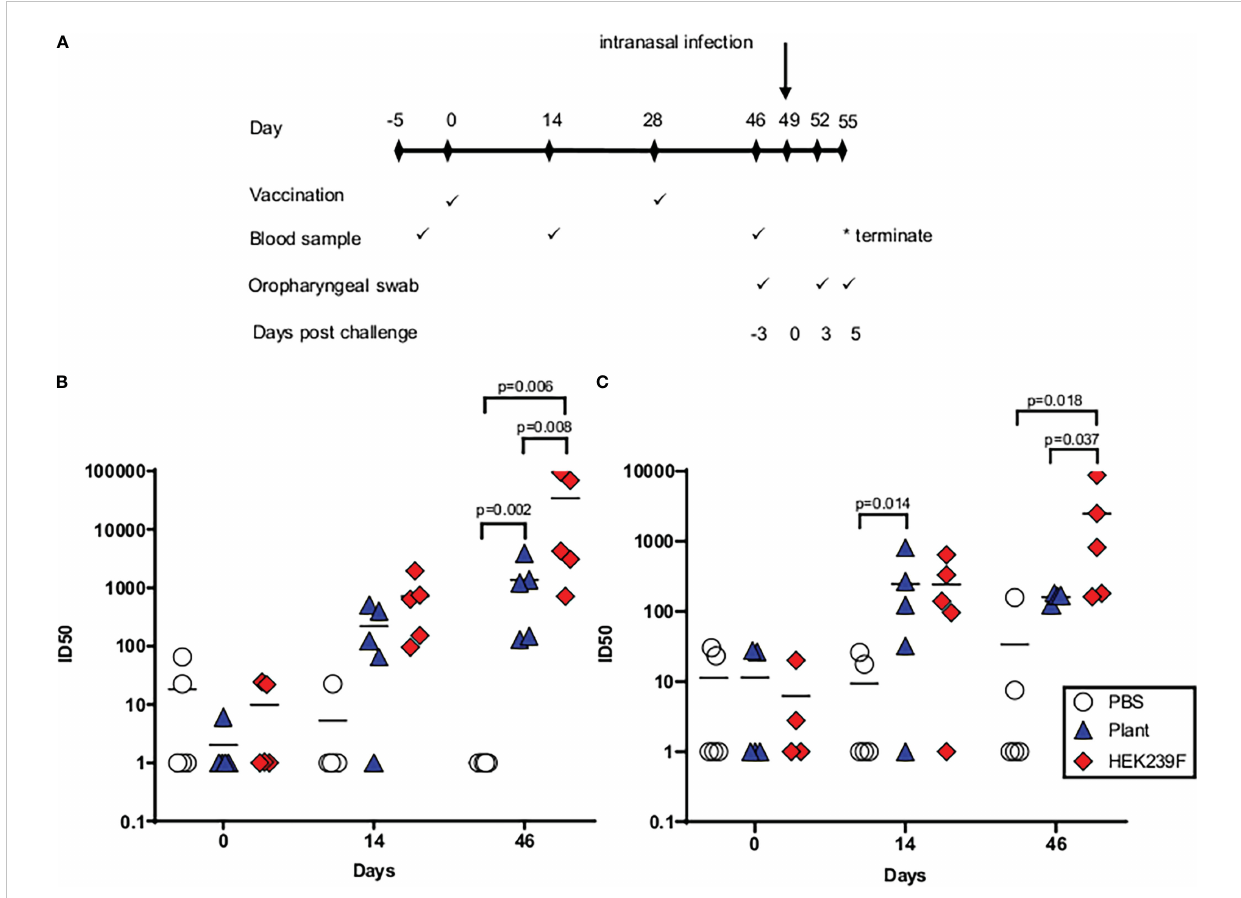
FIGURE 4 Immunogenicity of spike trimers in hamsters when produced in plants and mammalian cells. (A) Immunization schematic depicting the timing of immunizations and sampling during the experiment. (B) Neutralizing antibody titres (ID 50 ) against the matched wildtype (Wuhan) viral isolate. (C) Neutralizing antibody titres (ID 50 ) against heterologous Delta virus. Pre-bleed= day -2, fi rst bleed = day 14, fi nal bleed = day